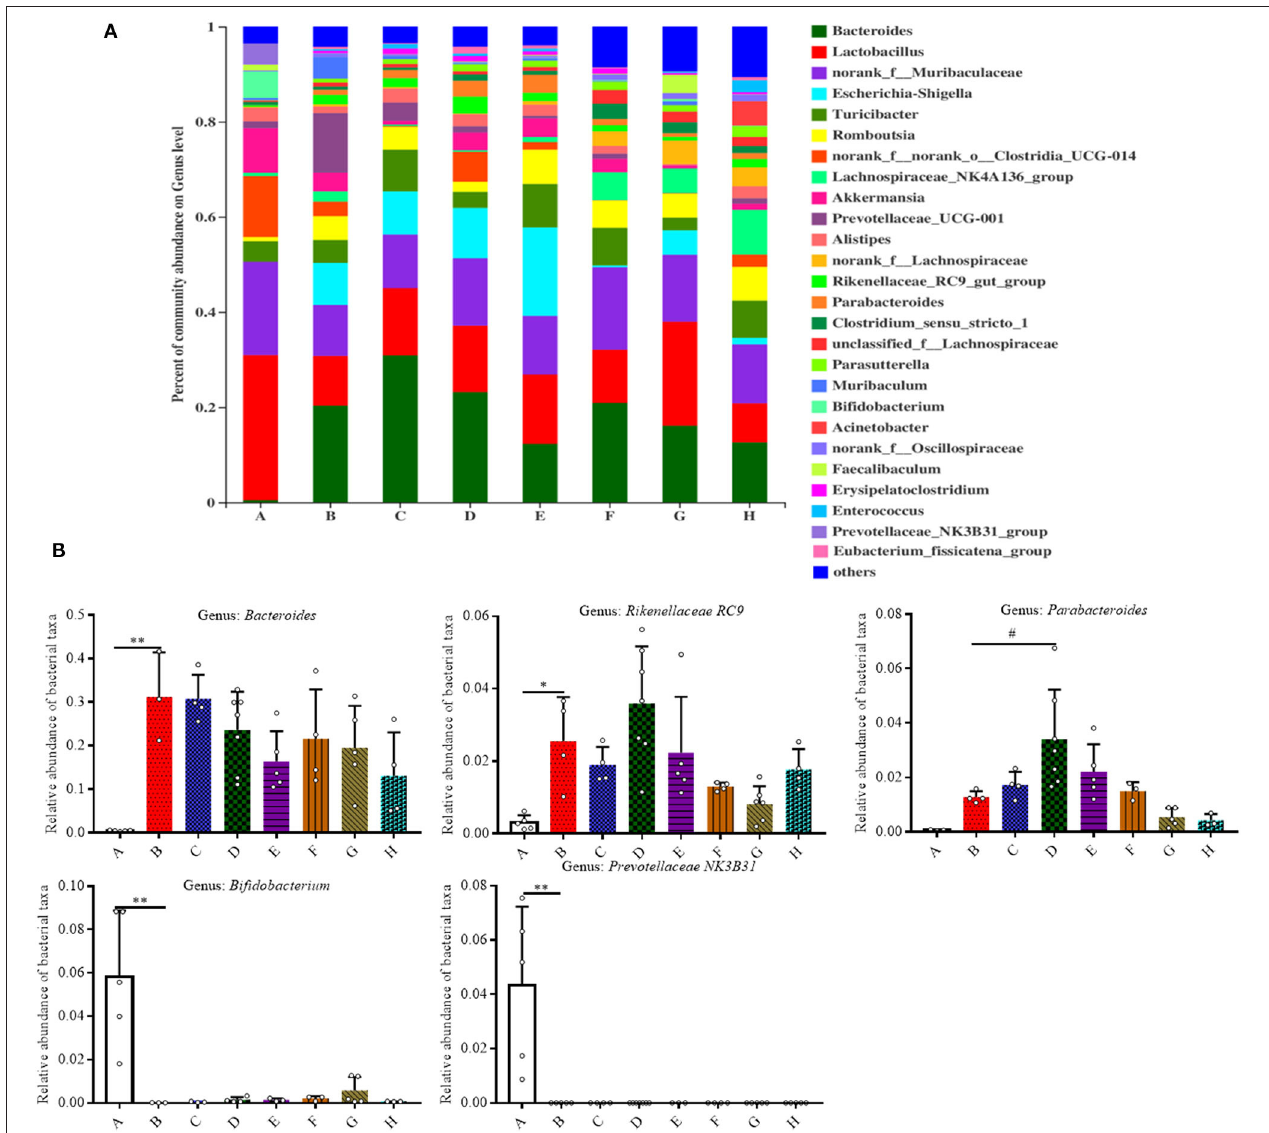
FIGURE 4 | Effect of SFN on gut microbiota compositions at the genus level in colitis mice. (A) Gut microbiota compositions at the genus level in each group. (B) Relative abundance of predominant bacterial community members at the genus level. All data are presented as the mean ± SD. P -value < 0.05 was considered to indicate statistical significance (* P < 0.05 and ** P < 0.01 compared with Group A, # P < 0.05 and ## P < 0.01 compared with Group